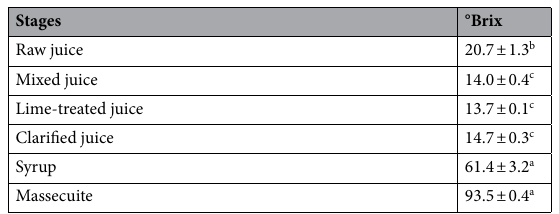
Table 1. Results of °Brix for the VHP sugar manufacturing stages. a,b,c,d,e Values with different superscript letters within the same columns are significantly different (p < 0.05) pelo teste de